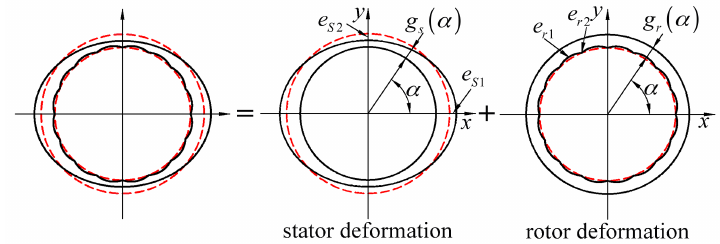
Figure 2. The analytical model of the IPMSM considering stator and rotor